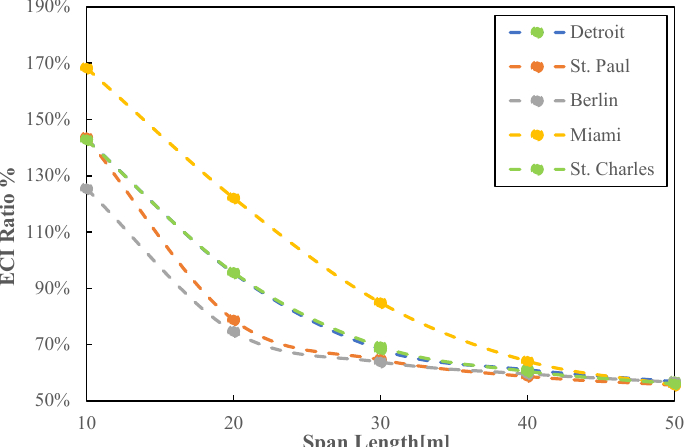
Figure 10. Varitation of the ECI ratio between the frames with 16 m and 6 m column heights with span